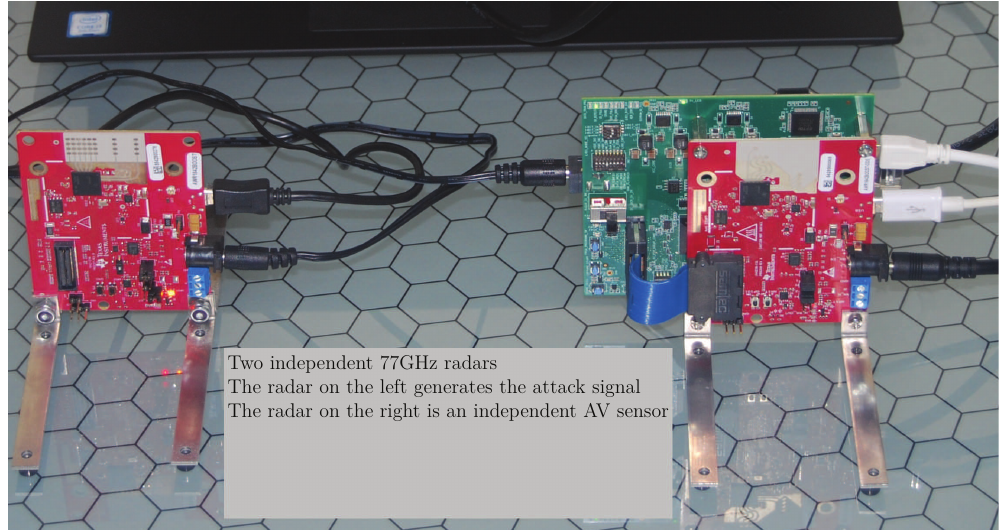
Figure 5. Our experimental setup consists of two 77 GHz radars. The radar on the left is used to generate the attack signal. The radar on the right is used as the AV radar sensor, and receives reflections of its own transmitted signal, as well as the attack signals generated by other